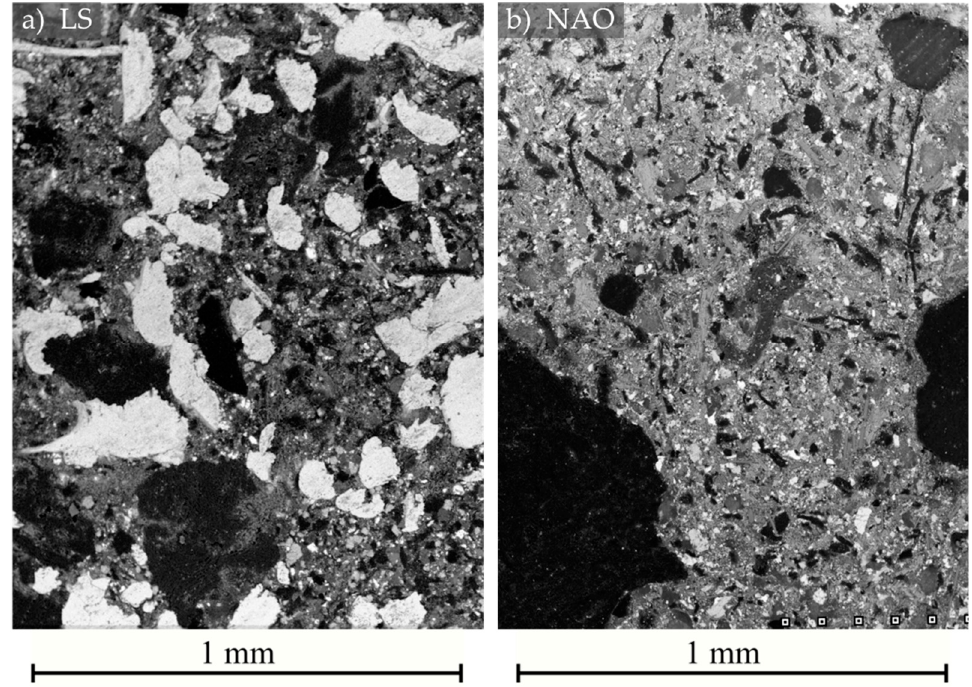
Figure 2. Microstructure of the materials: ( a ) LS formulation; ( b ) NAO formulation. SEM backscat- tered electron micrography. tered electron micrography.